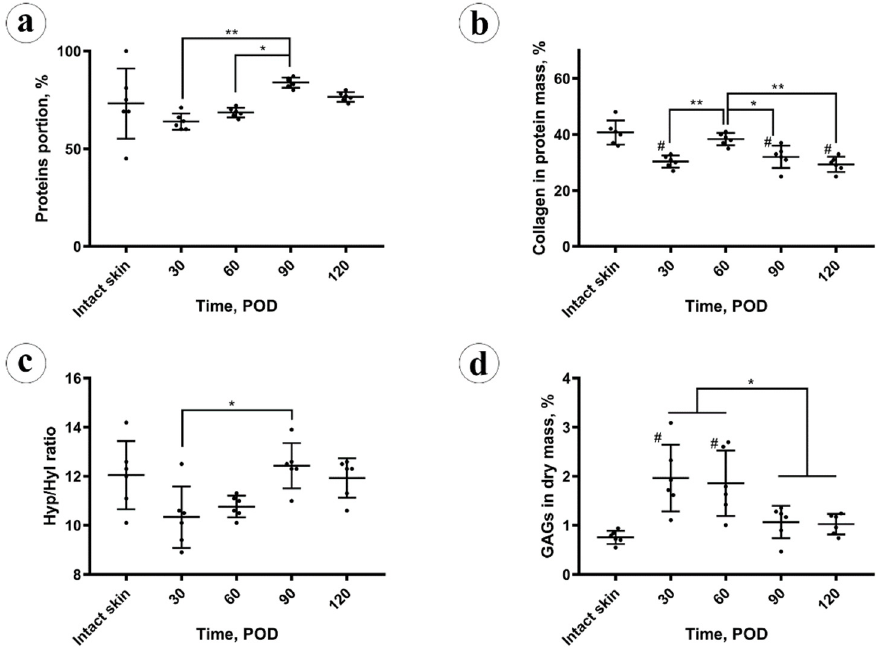
Figure 3. Chemical analysis: ( a ) protein amount; ( b ) collagen amount in the protein mass; ( c ) amino acid analysis; ( d ) spectrophotometry of glycosaminoglycans (GAGs). Statistical significance: * p ≤ 0.05, ** p ≤ 0.01. Mean values ± SD; # shows p ≤ 0.05 in comparison to control.